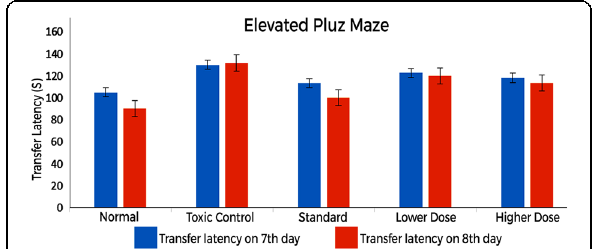
Fig. 11 Graphical representation of data obtained from elevated plus maze study